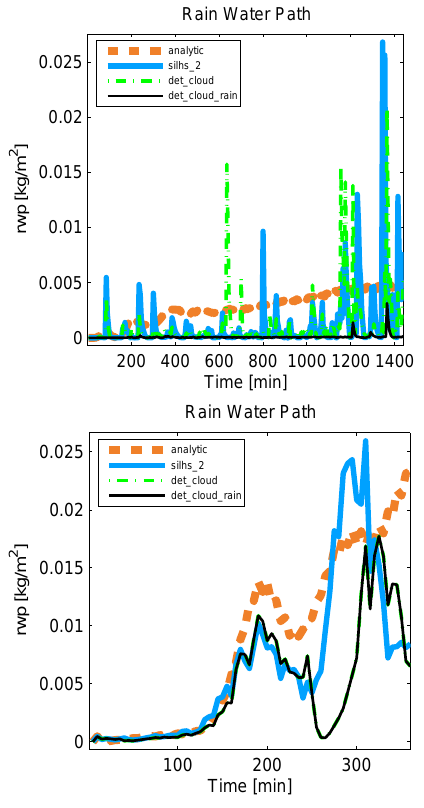
Fig. 5. Time series of rain water path from the RICO shallow cumulus simulation (upper panel) and from the DYCOMS-II RF02 marine stratocumulus simulation (lower panel). Shown are an analytic integration of the microphysics (orange dashed line), SILHS-based sampling with 2 points (light blue solid line), deterministic use of the within-cloud liquid cloud water mixing ratio (green dashed line), and deterministic use of within-cloud liquid and rain mixing ratio (black solid line). In the RICO case, treating liquid deterministically but not rain still permits sampling noise in the rain; treating both liquid and rain deterministically leads to an underprediction of